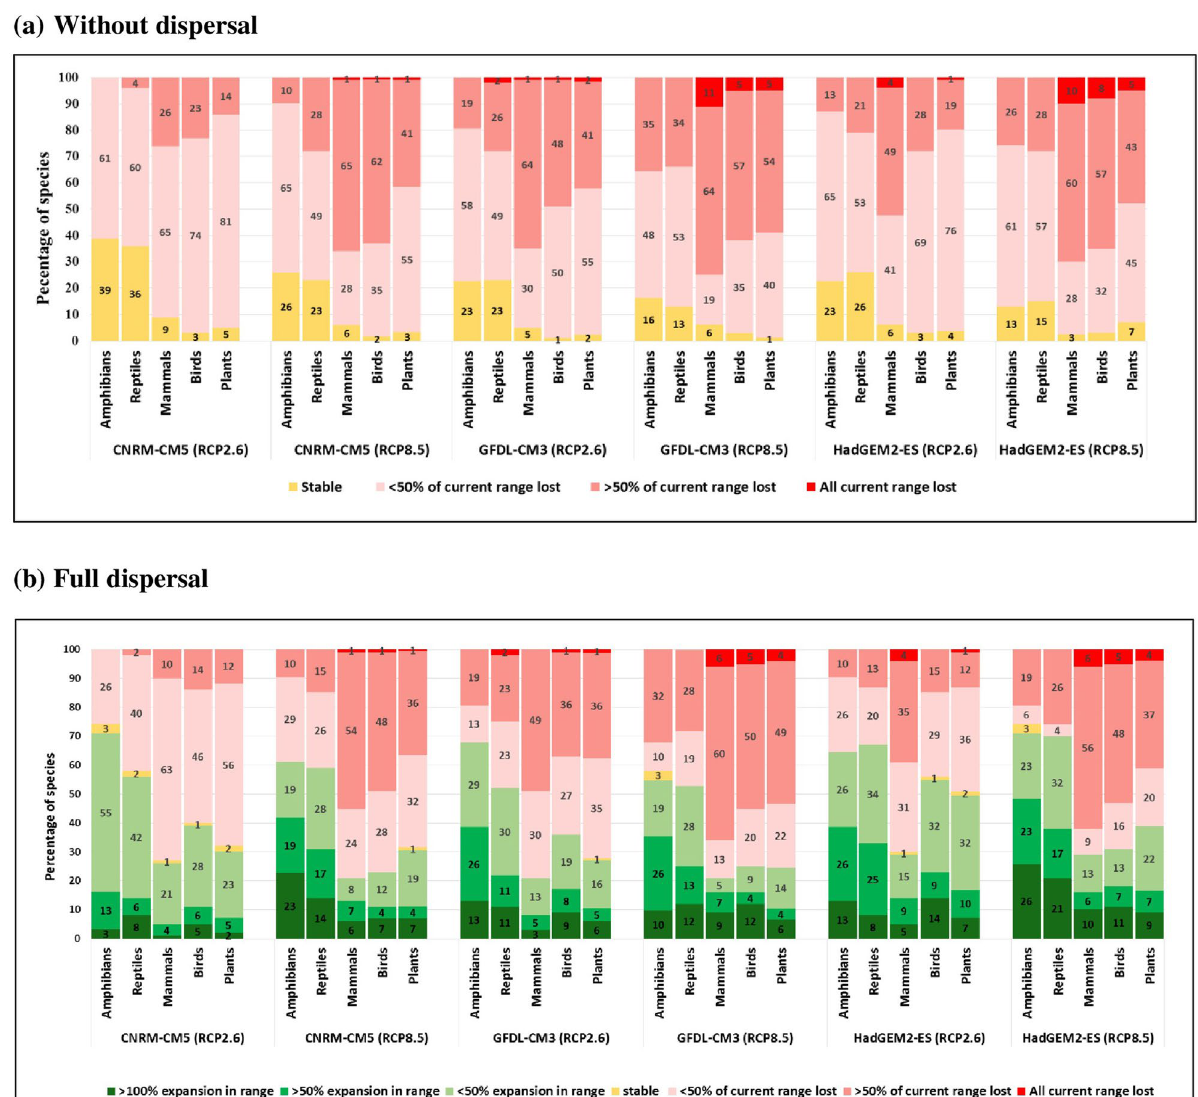
habitat loss, yellow stability, and green